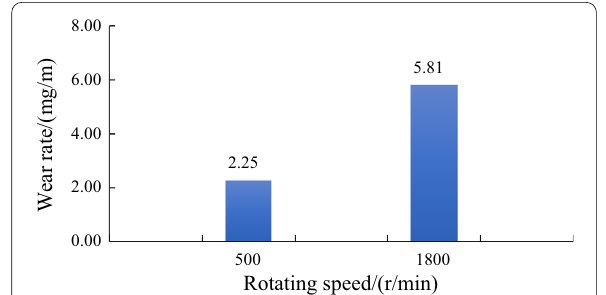
Figure 9 Wear rate of 500 r/min and 1800